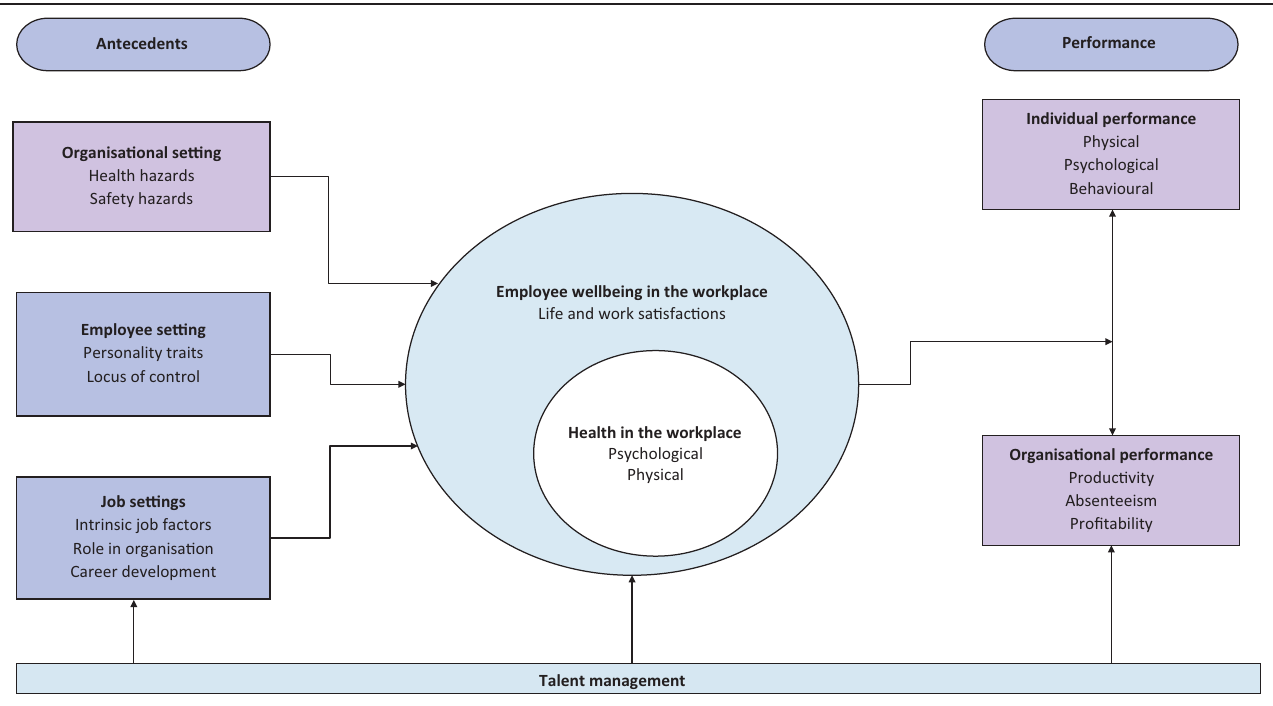
FIGURE 1: The interface between wellness, talent and